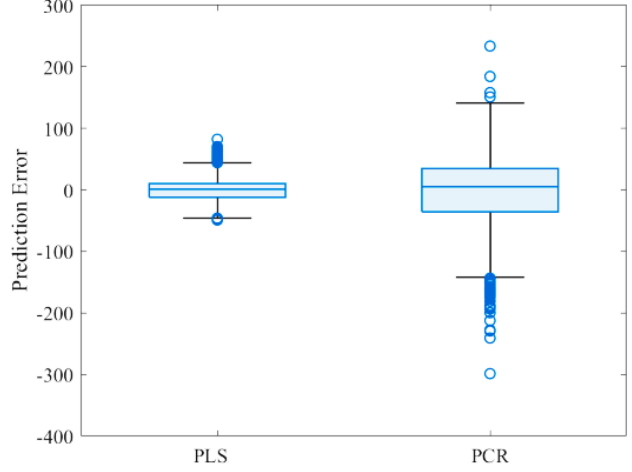
Figure 11. Box plot of residual errors of PLS and PCR models.